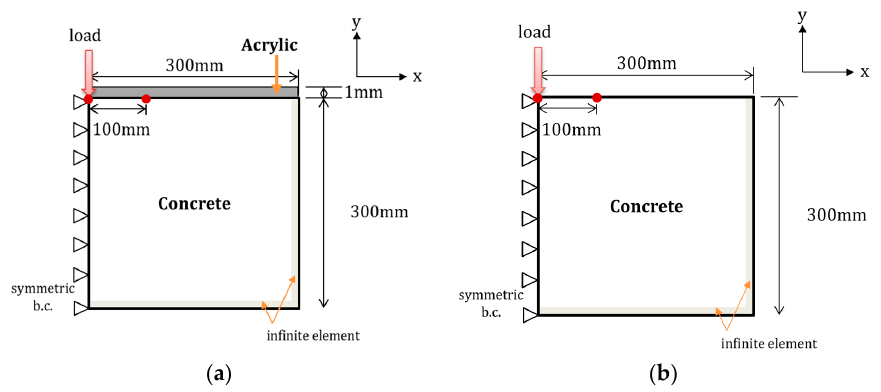
Figure 3. Configuration of finite element (FE) modeling: ( a ) with acrylic and ( b ) without acrylic.